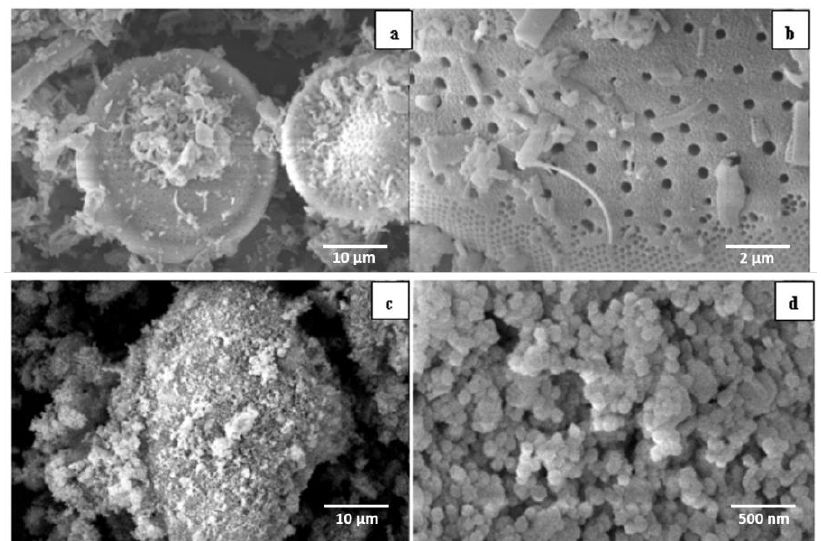
Figure 2. Scanning electron microscopy (SEM) images of Dt ( a , b ) and Dt/S-1 (5 wt%) ( c , d ).